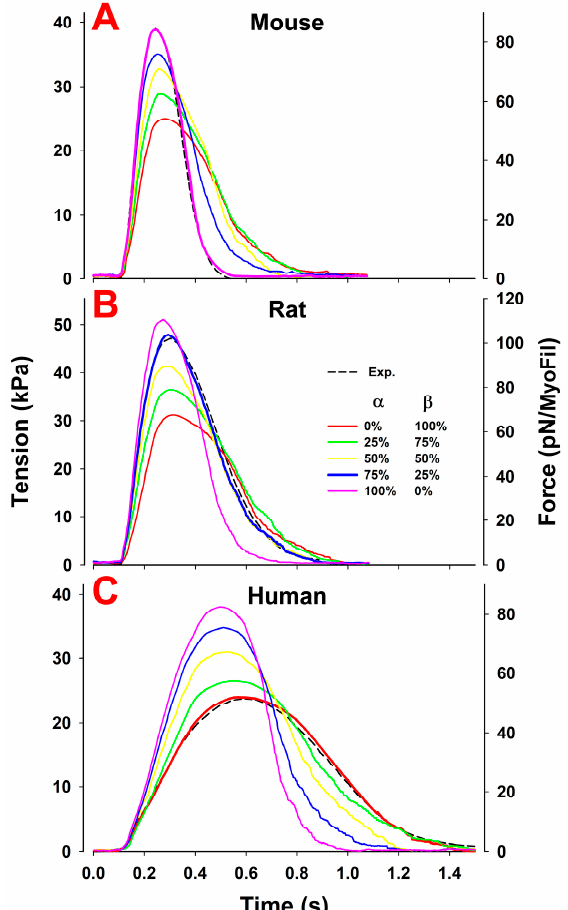
Figure 4. Effect of various fractions of α - and β -isoforms on twitch responses in fixed-end isometric conditions from mouse ( A ), rat ( B ) and human ( C ) trabeculae. The twitches show about the same twitch tension but the mouse ( A ) shows a much faster tension rise and tension relaxation than the rat ( B ). These parameters are much slower in the human for both the α - and β -isoforms ( C ), signifying differences in kinetics parameters of the same isoform across the species (Table 2). These responses were simulated assuming the same Ca 2+ transient as in Figure 2. The differences between the three species, therefore, also reflect the differences in the magnitude of the peak and duration of respective Ca 2+ transients.